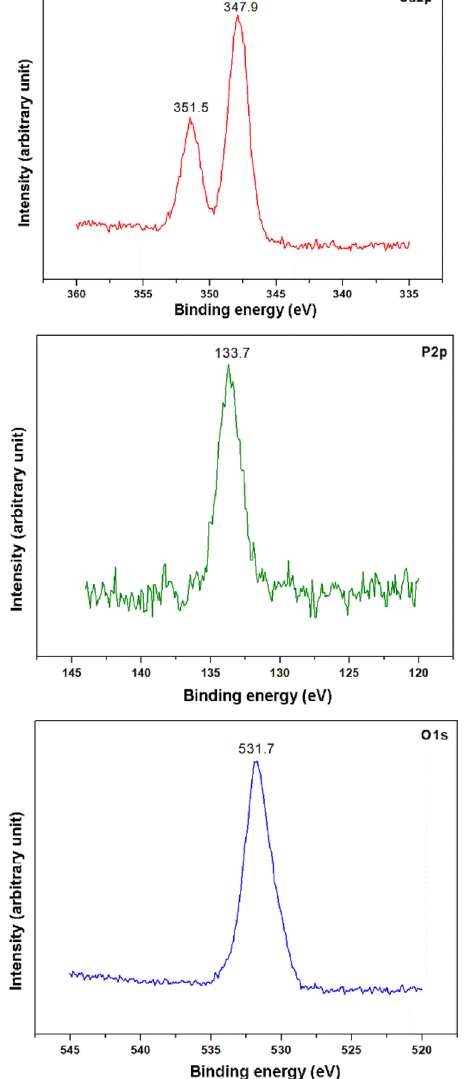
Fig. 12 Ca2p, P2p, and O1s XPS narrow spectra of ATF-D